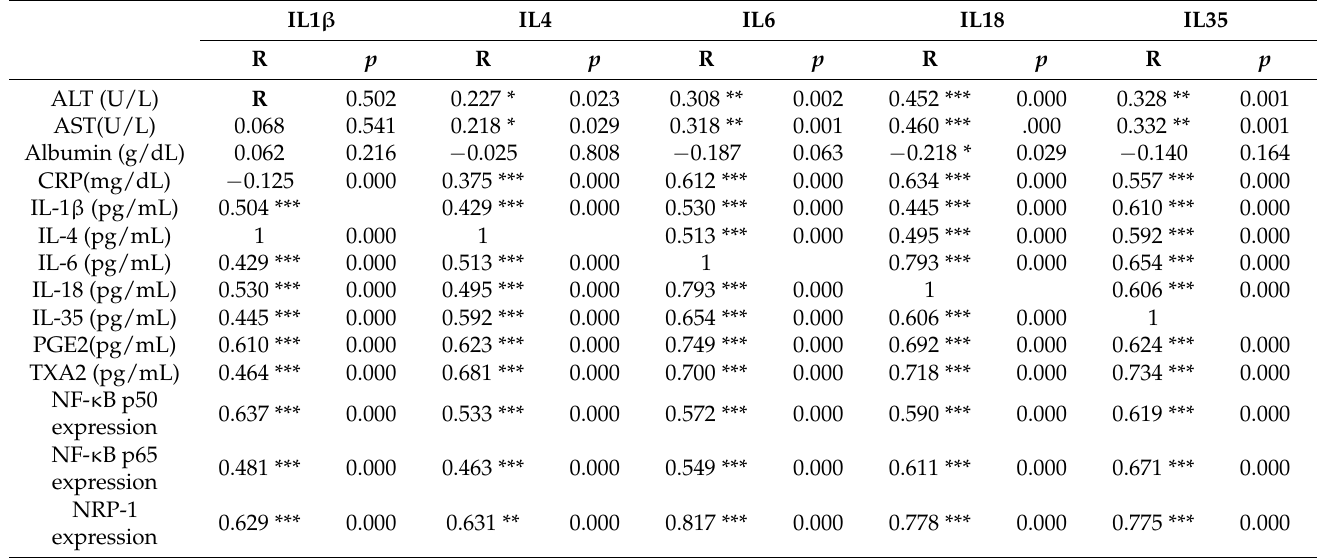
Table 3. Correlation between IL1 β , IL4, IL-6, IL-18, and IL-35 with all parameters in the moder- ate group.